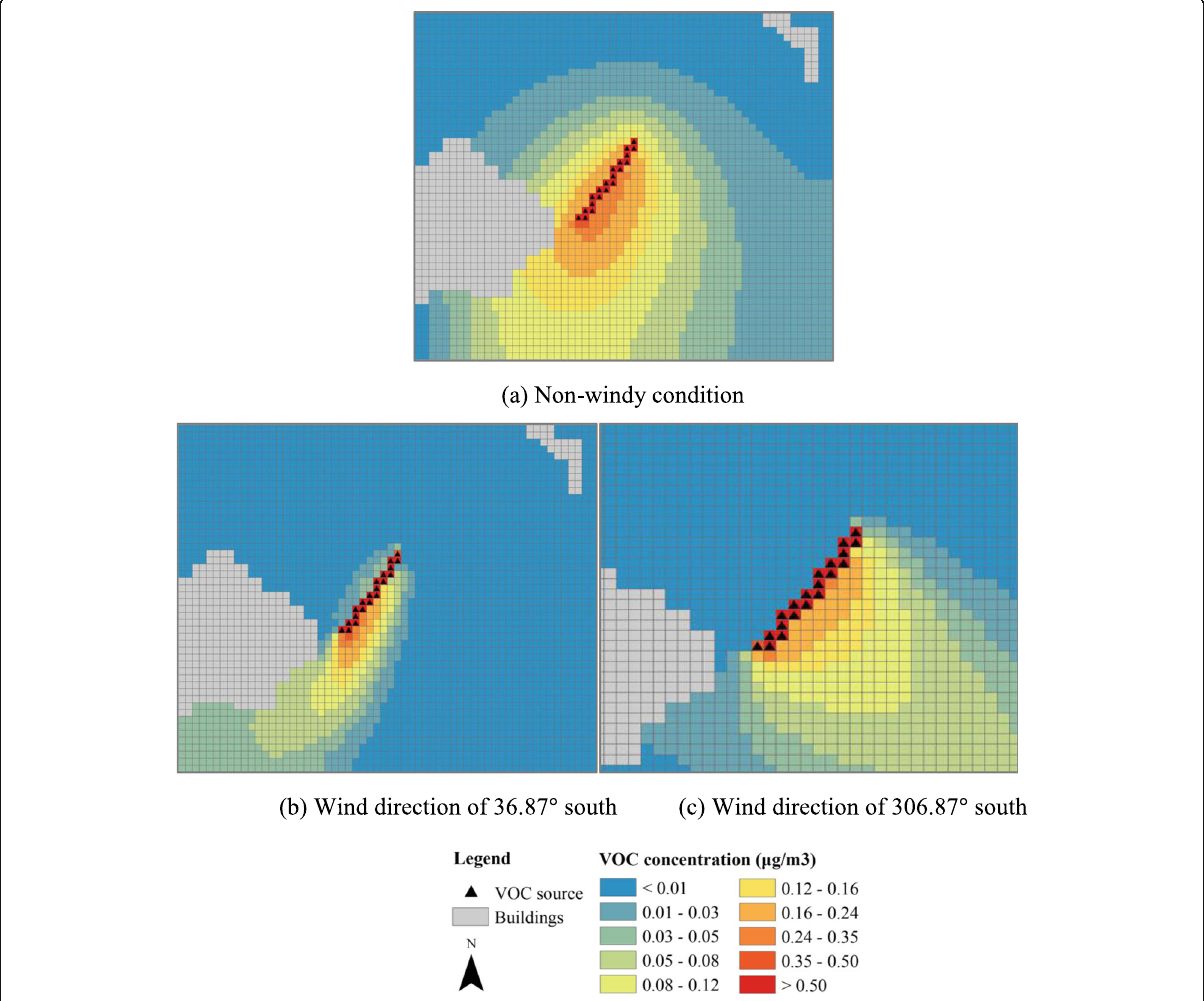
Fig. 10 VOC concentrations of a semi-closed green